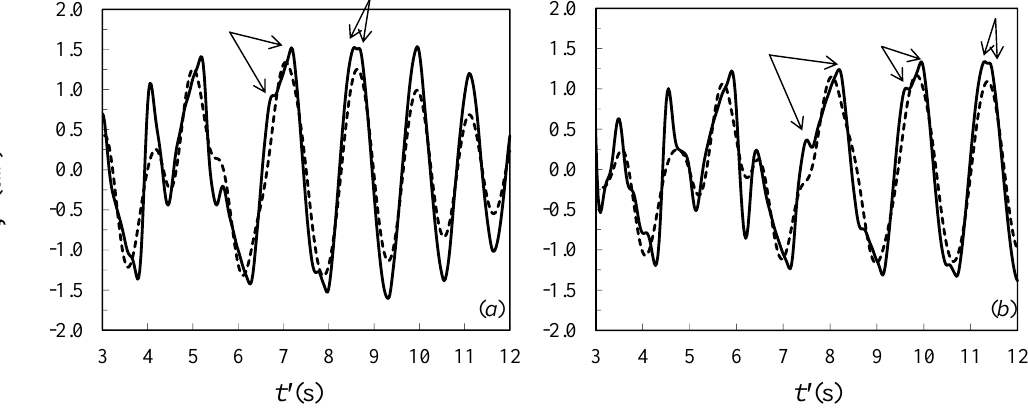
Fig. 8. Free-surface time series in physical variables at (a) (x 0 ,y 0 ) = ( 0 , 3 . 10m ) and (b) (x 0 ,y 0 ) = ( 0 , 4 . 07m ) . The bold dashed line represents the values of ζ 0 g for the infinite double Gaussian landslide, while the continuous line shows the values of ζ 0 p for the finite-length double parabolic landslide, both evaluated with the stationary-phase approximation formula. The first five modes have been considered for the double Gaussian slide, and the first seven modes for the double parabolic slide. The arrows show the double-crested waves in the perturbation generated by the double parabolic